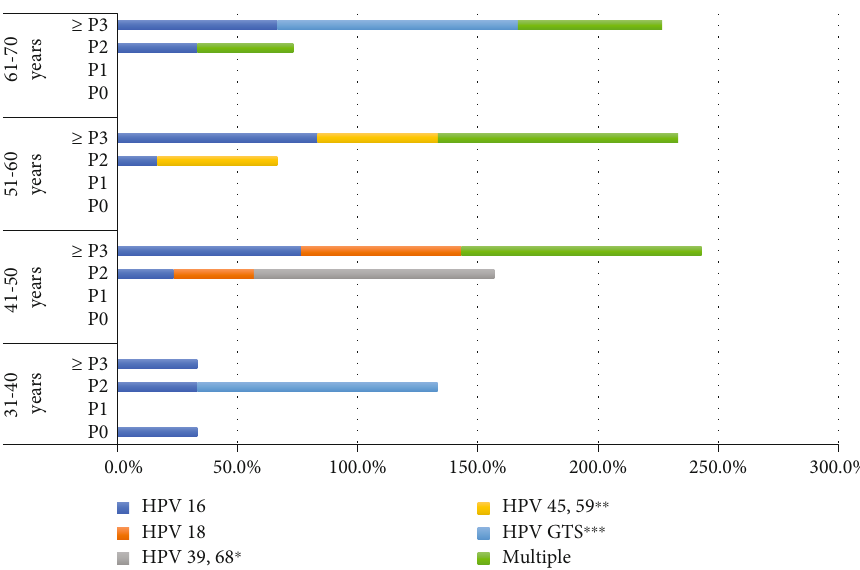
Figure 2: HPV genotype distribution by age and parity in HPV-positive